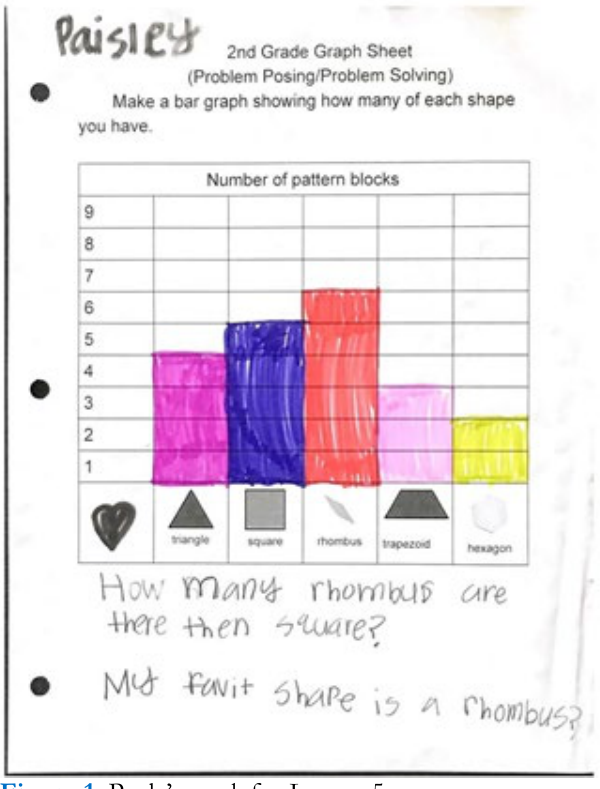
Figure 1. Paula’s work for Lesson